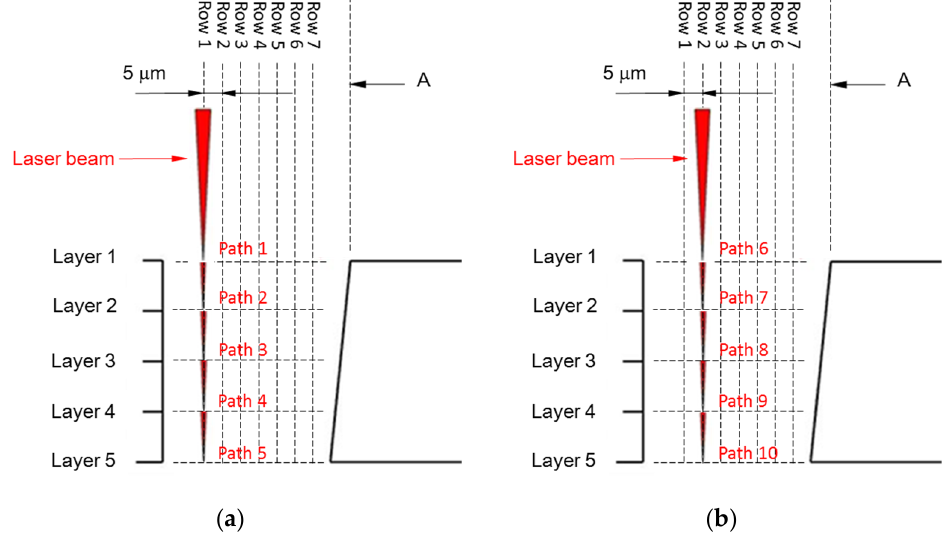
Figure 3. Laser finishing Method 1: ( a ) The starting position of the laser finishing process (Row 1) was set at 48 µ m to the left from the vertical Baseline A. The vertical direction along the Z-axis of the workpiece was processed first with 20 passes per path. After Layer 1 (Path 1) was processed, the workpiece stage is lifted by 100 µ m in the Z-axis direction to process Layer 2 (Path 2). The total number of Z-axis lifts was 4 (5 paths in total); ( b ) After processing all 5 layers in row 1, the stage was returned to its original position. The focal spot of the laser beam was shifted horizontally by 5 µ m to the right to process the following paths (from Path 6 to Path 10) in Row 2. The processing paths mentioned above were repeated until the number of horizontal shifts reachd6 (7 rows in